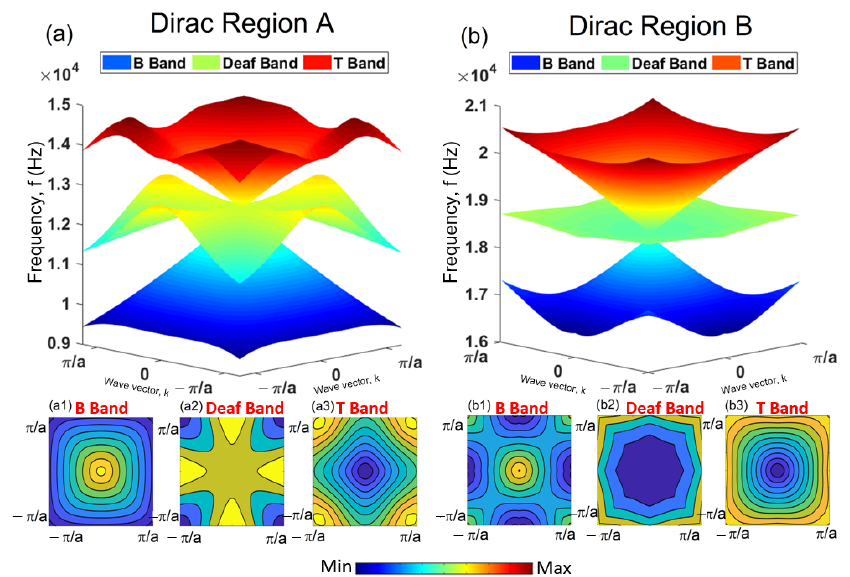
Figure 4. ( a , b ) depicts the equifrequency contours (EFC) for DRA and DRB while degenerated for θ = 9.7 ◦ , showing perfect triple degeneracy of Dirac cones at Γ of BZ. The equifrequency surfaces (EFS)